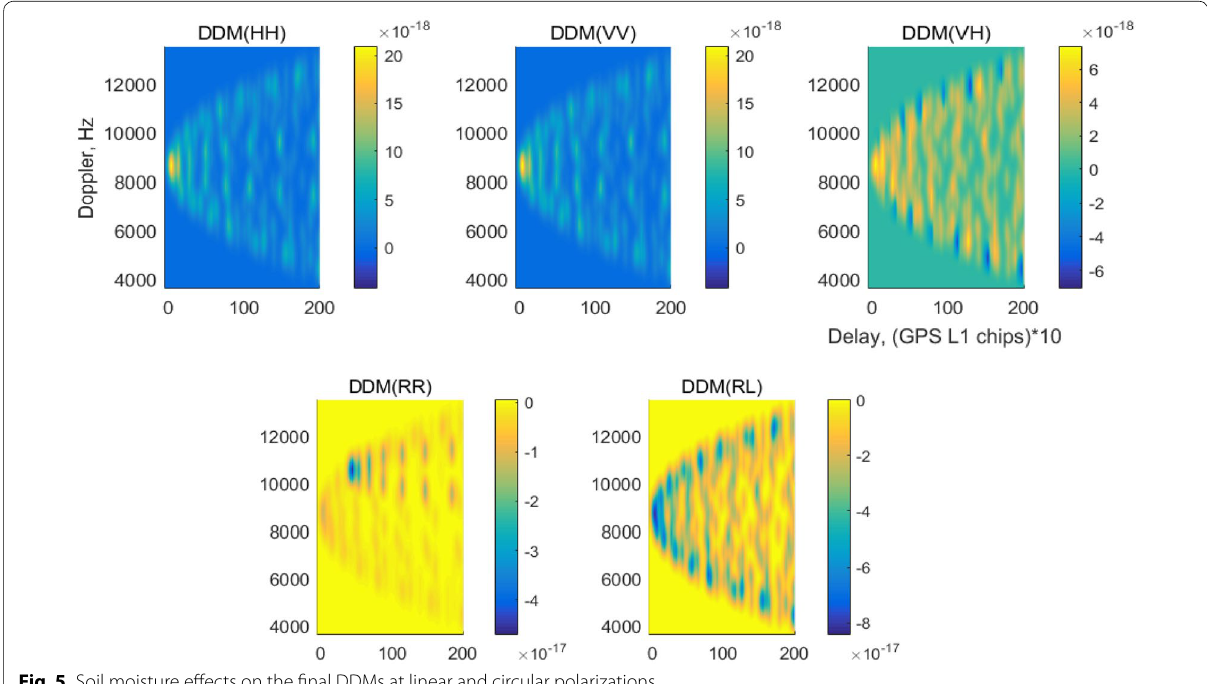
Fig. 5 Soil moisture effects on the final DDMs at linear and circular polarizations